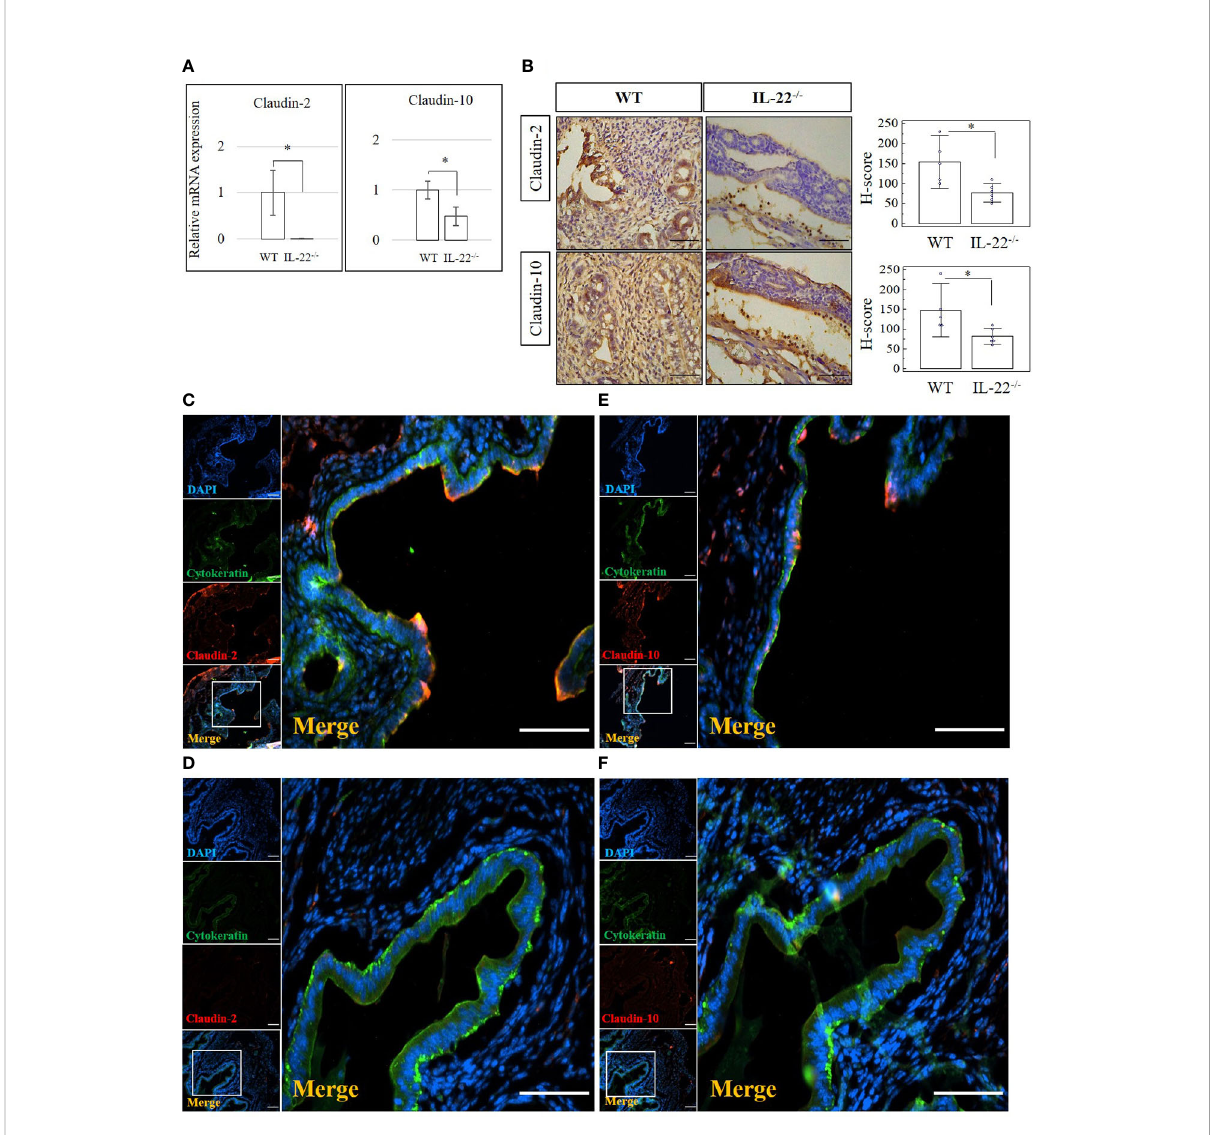
FIGURE 3 The expression of tight junction molecules in IL-22 − / − and WT mice. (A) IL-22 − / − , n = 6, and WT, n = 5, mouse uterine samples were harvested 48 h post intraperitoneal LPS injection. Total mRNA samples were extracted and processed by qRT-PCR to quantify the expression of tight junction molecules. The data are provided as mean ± SEM from three independent experiments. (B) IL-22 − / − , n = 6, and WT, n = 5, mouse uterine samples were harvested 48 h post intraperitoneal LPS injection, frozen fi xed, and processed for IHC analysis. Original magni fi cation, ×40; scale bar, 100 µm. H-score of tight junctions was calculated to measure whether the difference in the staining between the groups is statistically signi fi cant. The data from t-test are provided as mean ± SEM. (C – F) IF analysis of claudins ’ expression in WT (C, E) and IL-22 − / − mice (D, F) . Claudin-2 staining is shown in panels (C , D) and claudin-10 staining in panels E, F Small panels on the left demonstrate (from top to bottom) the following: nuclei staining in DAPI, blue; pan-cytokeratin staining in FITC, green; claudin-2 or claudin-10 in TRITC, red; merged image. Original magni fi cation, ×10. Large panels demonstrate insets shown on the merged images; original magni fi cation, ×20. Scale bar is 100 µm. WT, wild type; IL-22 − / − , IL-22 knockout; H-score, histological score; LPS, lipopolysaccharide; IHC, immunohistochemistry; IF, immuno fl uorescence; FITC, fl uorescein isothiocyanate. * p <